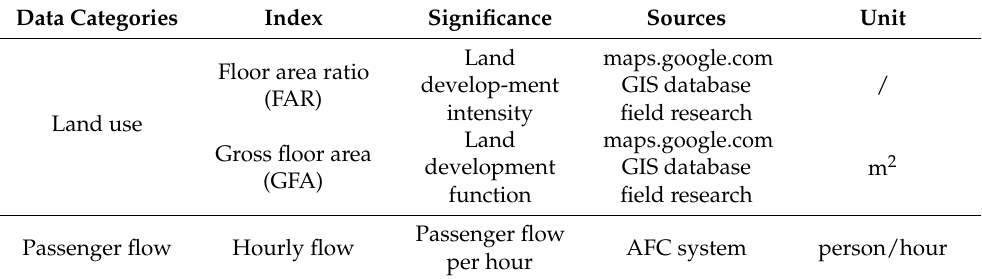
Table 1. Data categories and